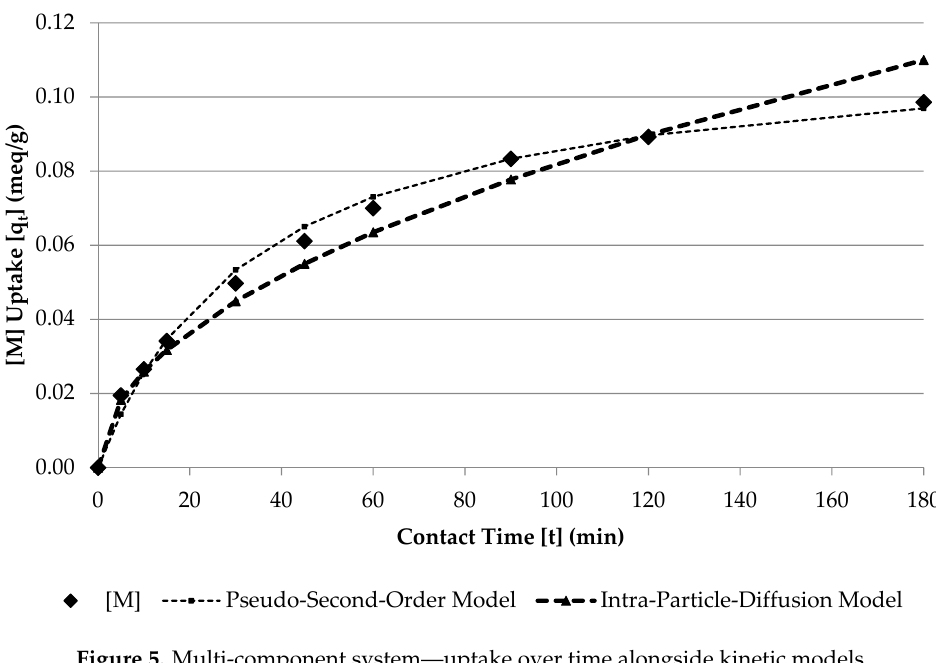
Figure 5. Multi-component system—uptake over time alongside kinetic models. Figure 5. Multi ‐ component system—uptake over time alongside kinetic models. Table 6. Experimental total (180 min) and theoretical equilibrium HMI uptake system